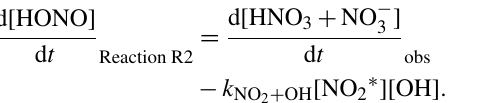
Figure 7. Calculated average sulfate production (a, c) and the con- tribution fraction (b, d) from SO 2 oxidation by H 2 O 2 , NO ∗ TMI under different pH conditions using the methods described in Cheng et al. (2016) for the case episodes on 4, 5, 11 and 14 Novem- ber